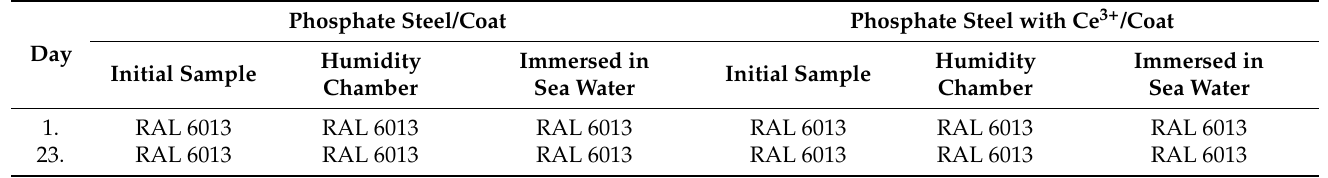
Table 8. Results of changing colors of samples in different corrosion